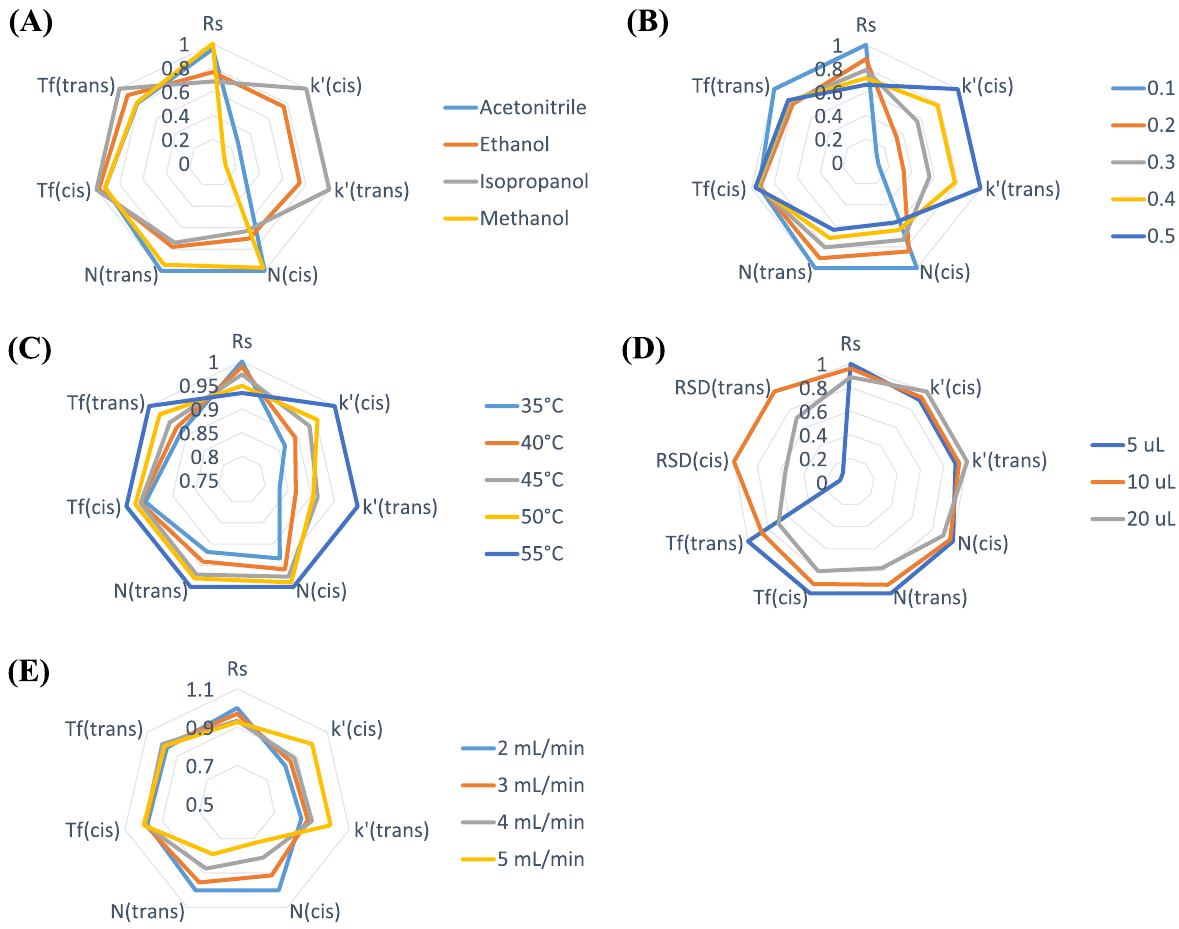
Fig. 2 Radar chart for peak parameters of teprenone isomers: ( A ) organic modifier type, ( B ) organic modifier content in mobile phase, ( C ) column temperature, ( D ) injection volume, and ( E ) flow